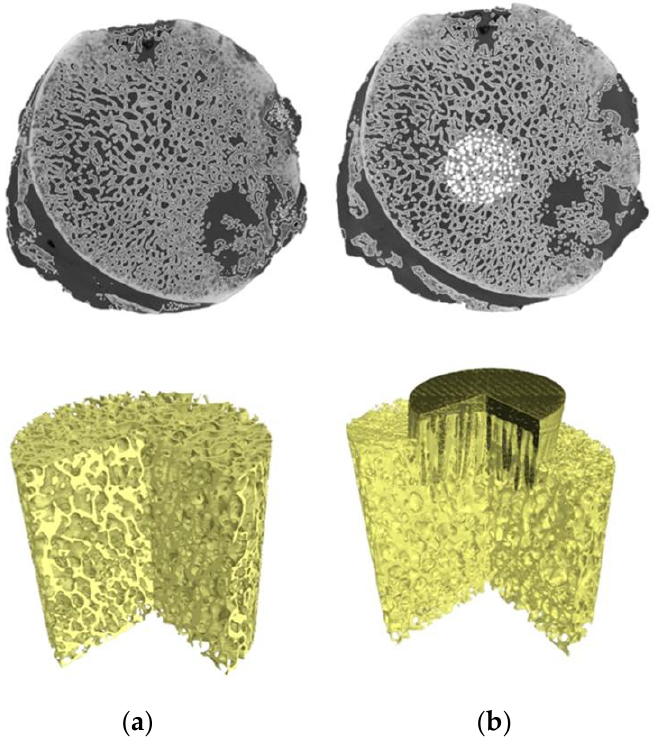
Figure 2. Micro-CT 3D reconstruction of femoral head bone samples: ( a ) before and ( b ) after embedding of MSC-Scaffold prototype.